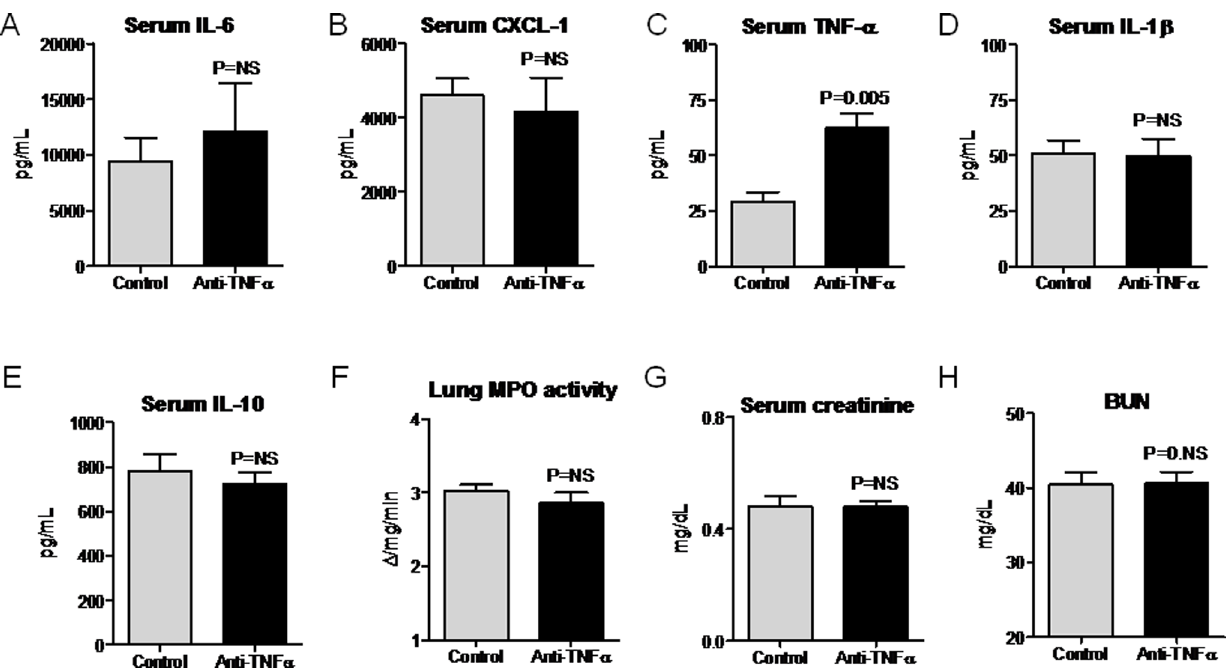
Figure 9. Serum cytokines, lung MPO activity, serum creatinine, and BUN in mice treated with anti-TNF- a therapy 2 hours after intraperitoneal (IP) endotoxin administration. Serum (A) IL-6, (B) CXCL1, (C) TNF- a , (D) IL-1 b , (E) IL-10, and (F) lung MPO activity, and (G) serum creatinine, and (H) BUN were determined 4 hours after IP endotoxin in mice treated with anti-TNF- a antibody (Anti-TNF- a ) or control 2 hours after endotoxin administration; n=5. The serum proinflammatory cytokines IL-6, CXCL1, and IL-1 b , serum IL-10, lung MPO activity, creatinine, and BUN were not affected by post-treatment with anti-TNF- a antibody.